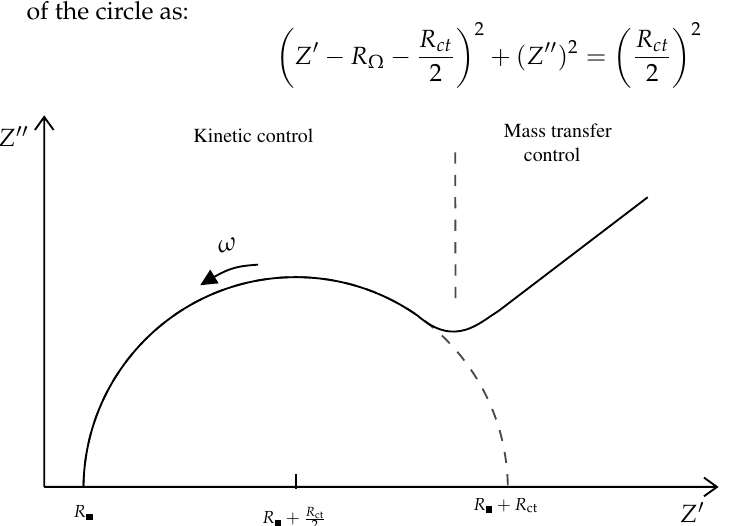
Figure 3. Illustration of a polar plot for the Randle’s circuit